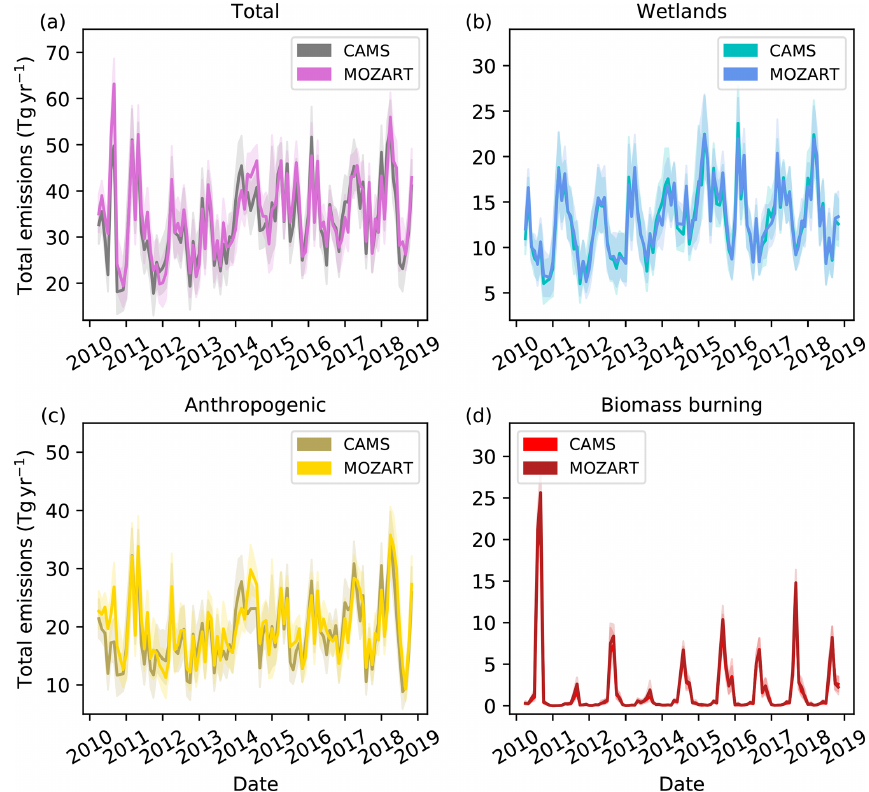
Figure A9. Brazil’s CH 4 emissions in a sensitivity inversion using perturbed a priori boundary conditions from the MOZART model. All other components were held at the original configuration. (a) Total, (b) wetland, (c) anthropogenic and (d) biomass burning emissions. A priori emissions do not vary in this